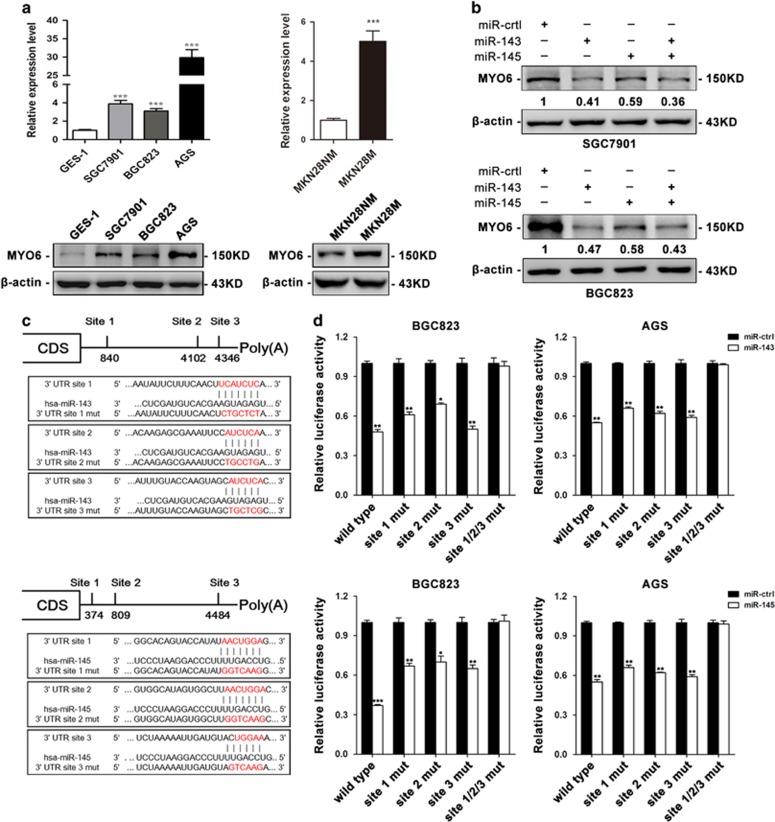
miR-143 and miR-145 inhibit MYO6 expression by targeting its 3′-UTR. (a) mRNA expression levels of MYO6 (predicted target gene) in three gastric cancer cell lines, normal gastric epithelial cells and low and high-metastatic gastric cancer cell lines. (b) The protein expression level of MYO6 in SGC7901 and BGC823 cells after transfection with miR-143 and/or miR-145 mimics or miR-ctrl. (c) Diagram of the MYO6 3′-UTR-containing reporter construct. Mutations were generated at three predicted miR-143 and miR-145 binding sites located in the MYO6 3′-UTR. (d) Representative luciferase activity in BGC823 and AGS cells co-transfected with wild-type or mutated reporter plasmids and miR-ctrl, miR-143 or miR-145. *P<0.05, **P<0.01, ***P<0.001